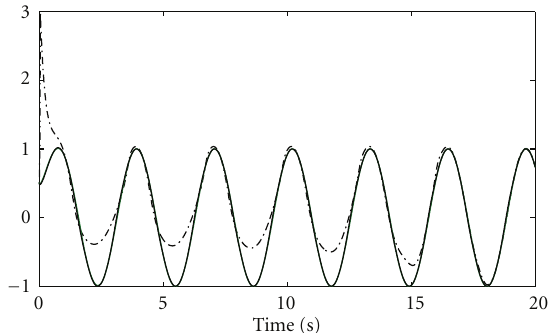
Figure 4: The redistribution trajectory of the identification models.